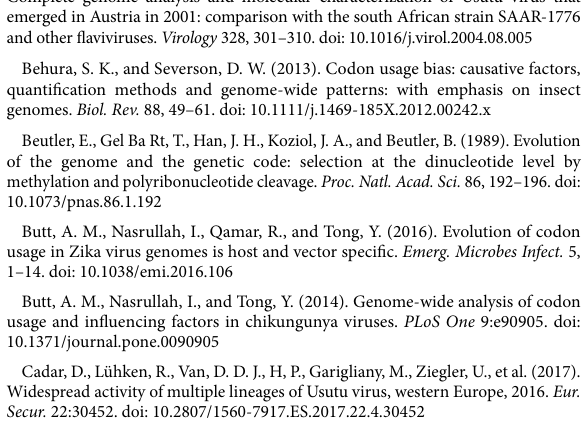
SUPPLEMENTARY FIGURE 1 Boxplots of the GC, GC percentage at the first (GC1s), second (GC2s), third (GC3s) codon position values of USUV strain in various lineages (A) , isolation hosts (B) , and different genes (C) . Every point represents a strain. All differences with P < 0.01 are indicated. ** P < 0.001; *** P < 0.0001; using two-sided unpaired Wilcoxon rank test (BH-corrected). SUPPLEMENTARY FIGURE 2 The effective number of codons (ENC) values distribution. (A) The overall ENC values comparison among the different genes. (B–K) show the ENC values of various lineages of the ten genes, respectively. All differences with P < 0.01 are indicated. ** P < 0.001; *** P < 0.0001; using two-sided Dunn’s test (BH-corrected). SUPPLEMENTARY FIGURE 3 The relative abundance of 16 dinucleotides in ten genes. Different colors represent lineage classification. The black dash lines indicate 1.23 and 0.78, respectively. The grey line indicates the expected frequency (1.0). SUPPLEMENTARY FIGURE 4 The effective number of codons (ENC) plots of different genes of the 368 USUV strains. The solid curve represents the expected ENC values when the codon usage was only influenced by the GC3s composition. The point shape and color are depicted according to isolation host and lineage classification. SUPPLEMENTARY FIGURE 5 Spearman’s correlation analysis among the nucleotide composition, the effective number of codons (ENC), Aromo, Gravy, and the first two axes of Principal component analysis (PCA) in USUV complete coding sequences. Dark red and blue means positive and negative correlation, respectively. Deeper color darkness means a higher correlation. Non-significant ( P < 0.05) correlations are not shown. SUPPLEMENTARY FIGURE 6 Neutrality analysis of the USUV genes for all strains (A) and different lineages (B)